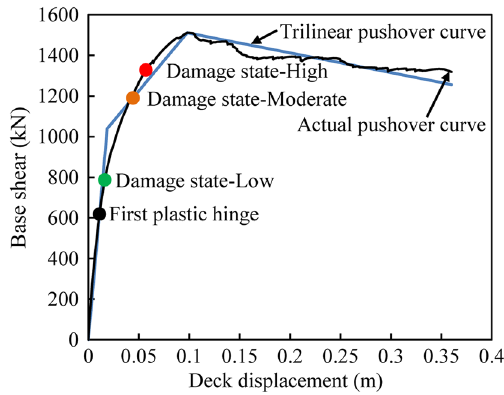
Fig. 5 Pushover curve for cast-in-situ pile-supported wharf